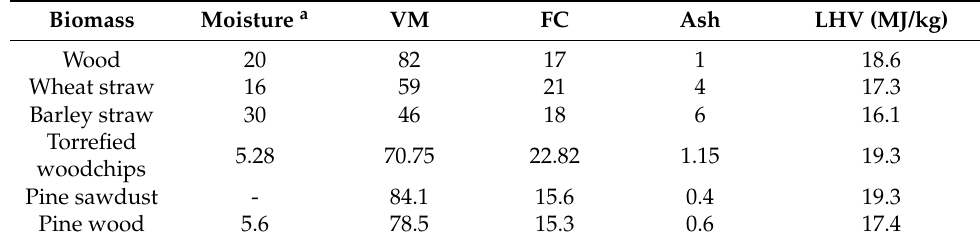
Table 5. Proximate analysis of some biomass feedstock (wt.%) [32,33,47,49].